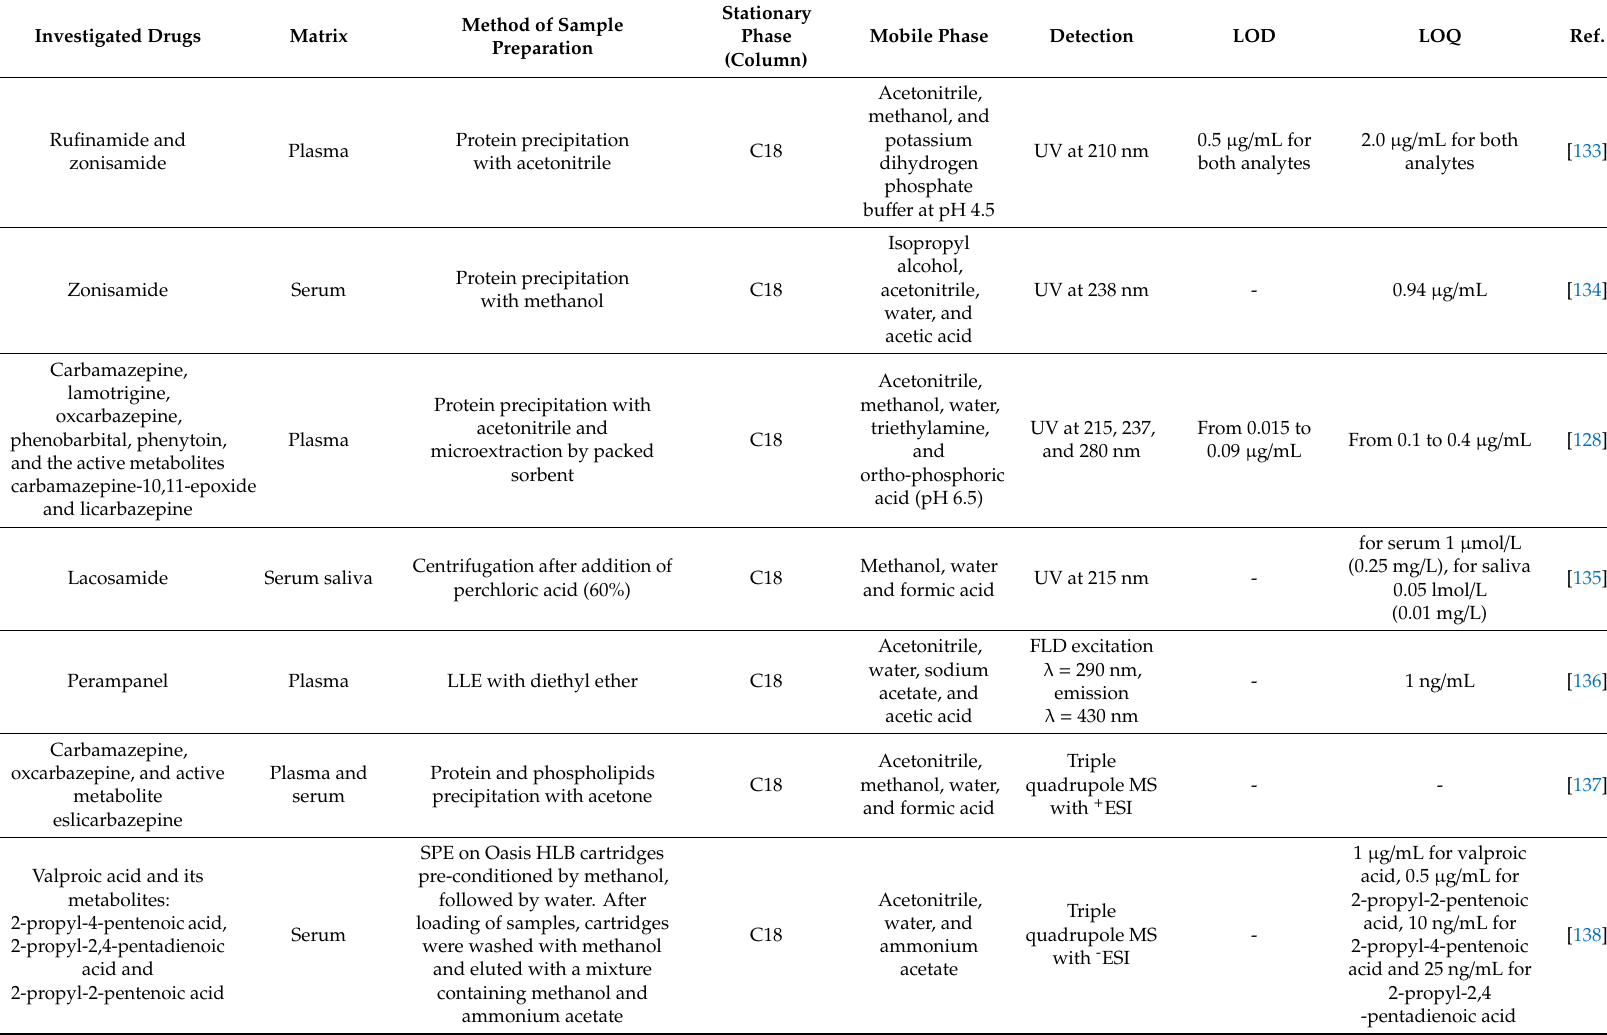
Table 8. Antiepileptic